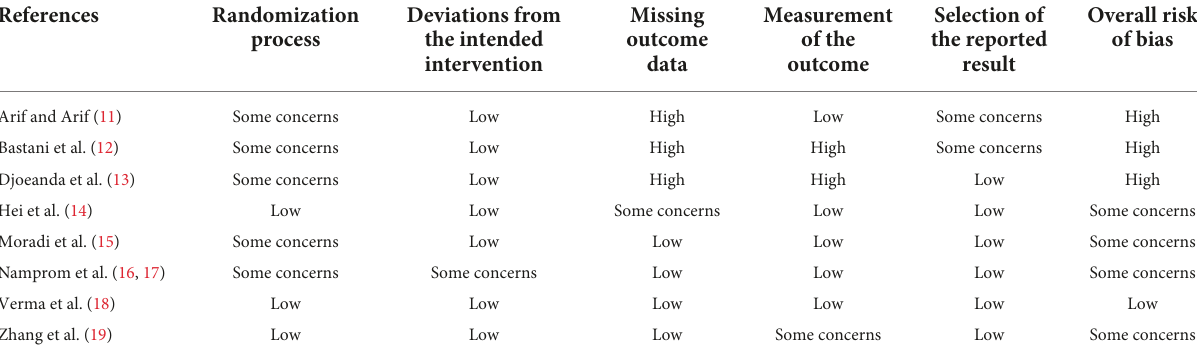
TABLE 1 Risk of bias of randomized controlled trials using RoB 2 tool (9).